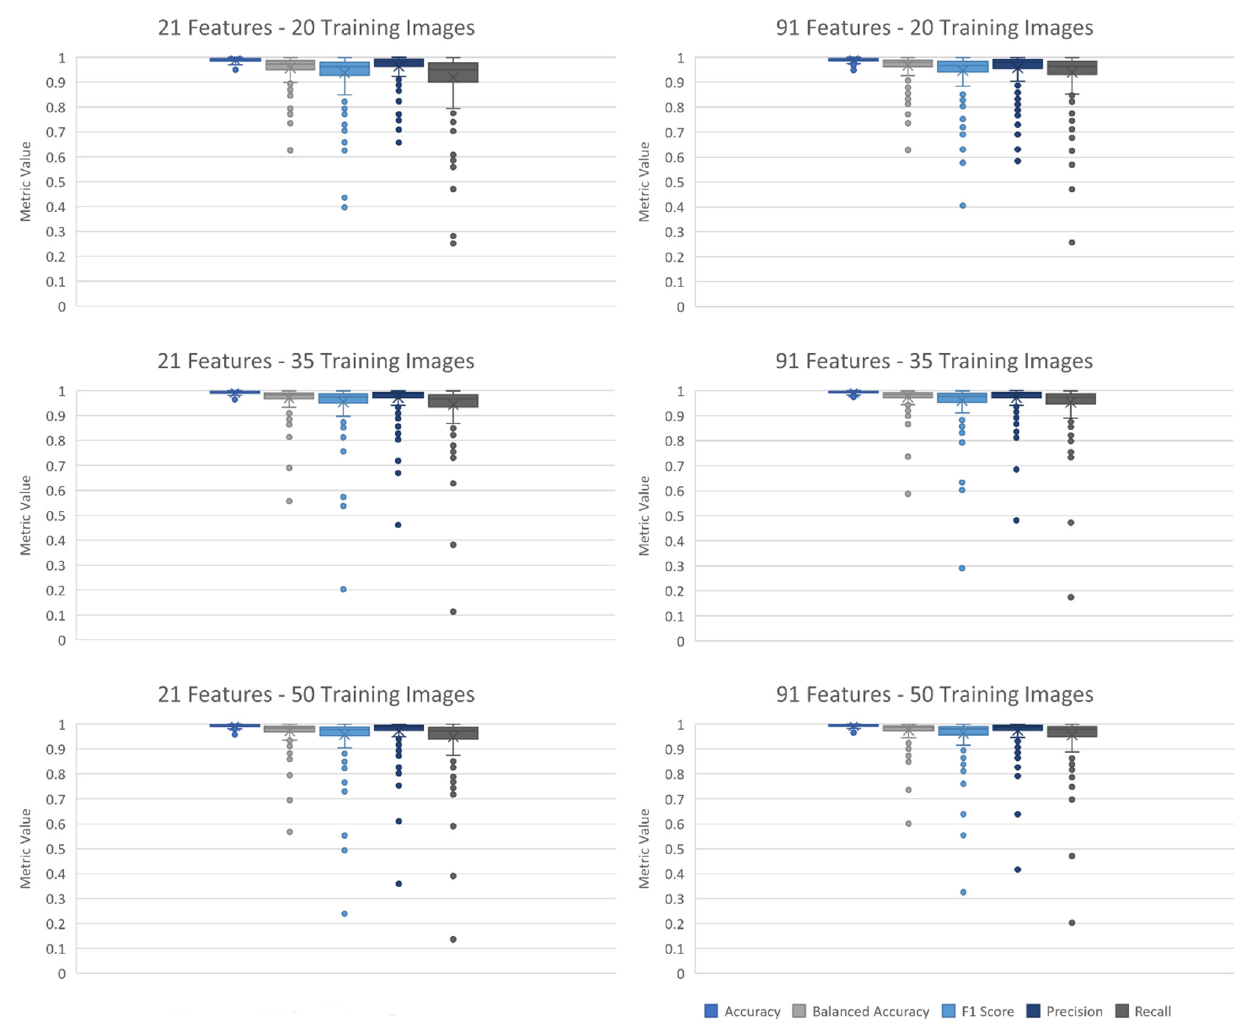
Figure 5. Metrics for texture-feature trained random forest classifiers by feature number and training set size.